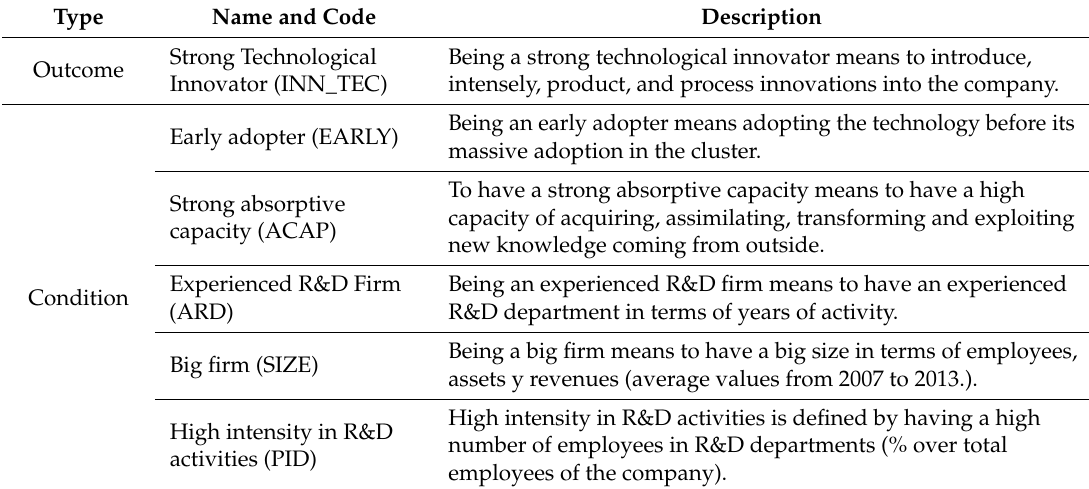
Table 2. Outcome and conditions: description and codifications.